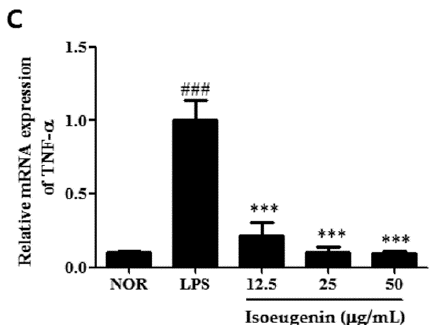
Figure 4. Inhibitory effect of isoeugenin on LPS-induced TNF- α ( A ); IL-6 ( B ); IL-1 β ( C ) mRNA expression in RAW264.7 cells. Total RNA was prepared for the Real Time-PCR analysis of TNF- α , IL-6, IL-1 β gene expression from RAW264.7 macrophage cells pretreated with different concentrations (12.5, 25, 50 μ g/mL) of isoeugenin for 1 h followed by LPS (1 μ g/mL) for 24 h. NOR values were obtained in the absence of LPS and samples. The experiment was repeated three times and similar results were obtained. Values represent means ± S.D. of three independent experiments. ## p < 0.01, ### p < 0.001 vs. the control group; * p < 0.05, ** p < 0.01, *** p < 0.001 vs. 1 μ g/mL LPS-treated group; significant differences between treated groups were determined using ANOVA and Dunnett’s post hoc test.